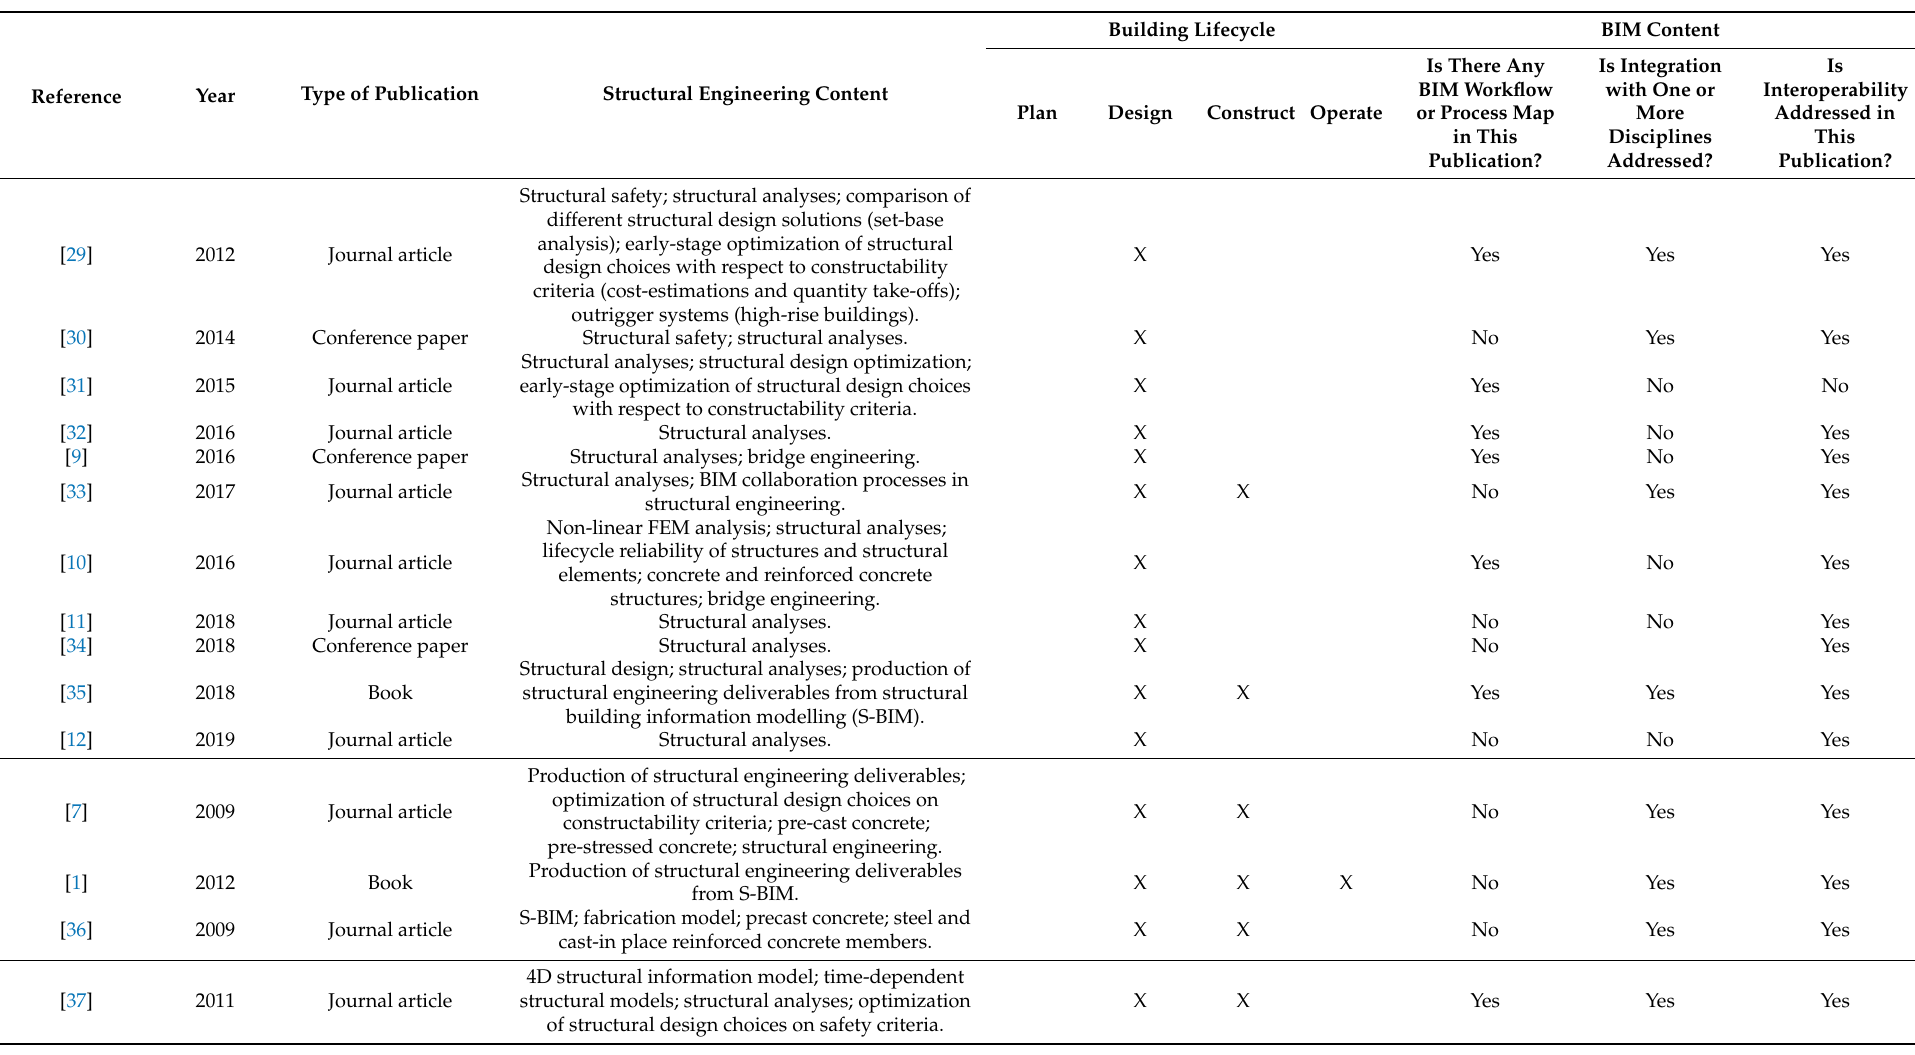
Table 1. Results of literature search on the use of BIM in structural